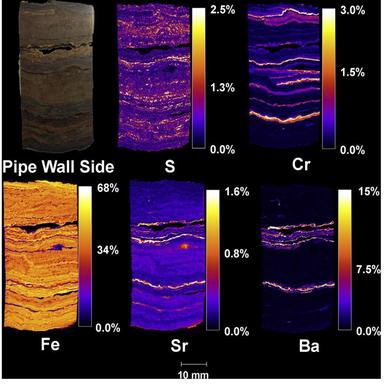
Micro-XRF mapping of sample 2.